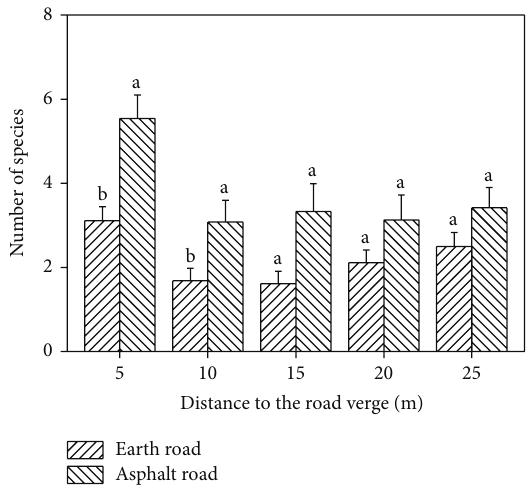
Figure 2: Number of species in plots of asphalt roadsides and earth roadsides.Lettersaboveerrorbarofeachcolumnindicatesignificant difference at the 𝑃 < 0.05 level for Student’s 𝑡